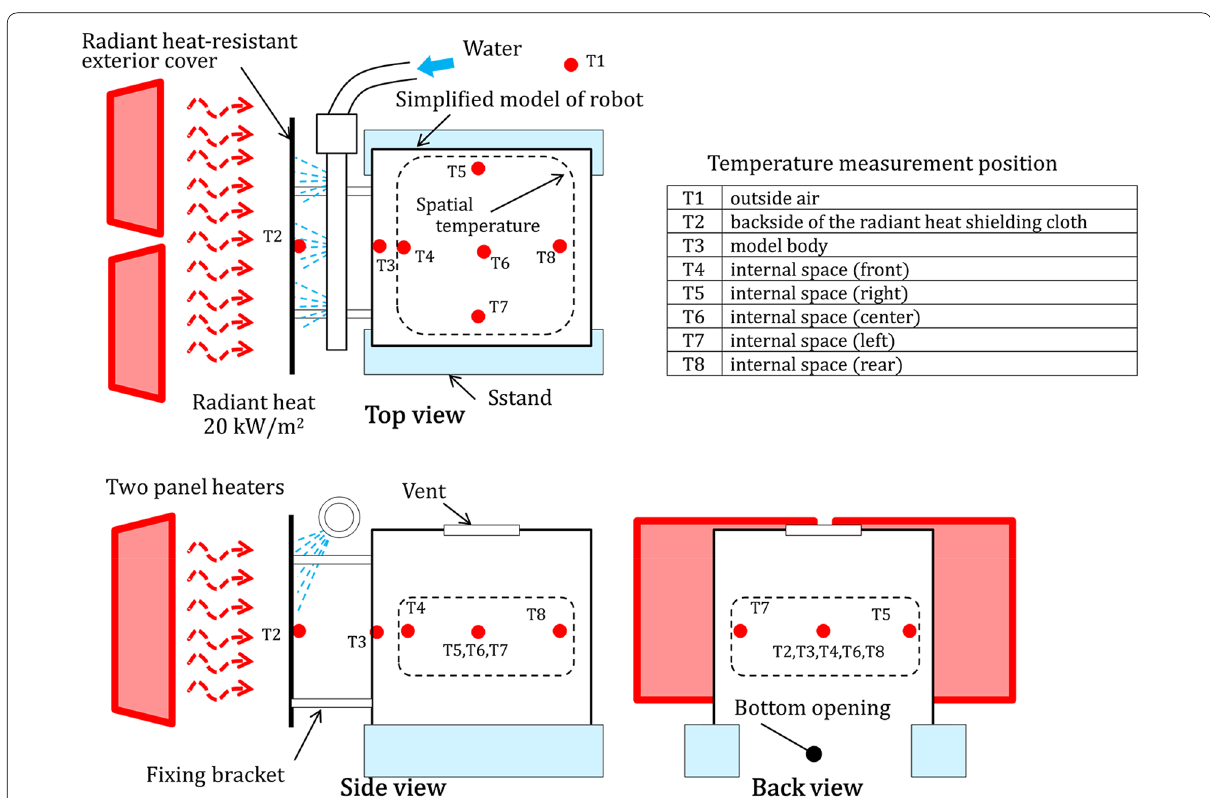
Fig. 8 Schematic diagram of the radiation heat-transfer experiment using a simplified robot model with the radiant heat-resistant exterior